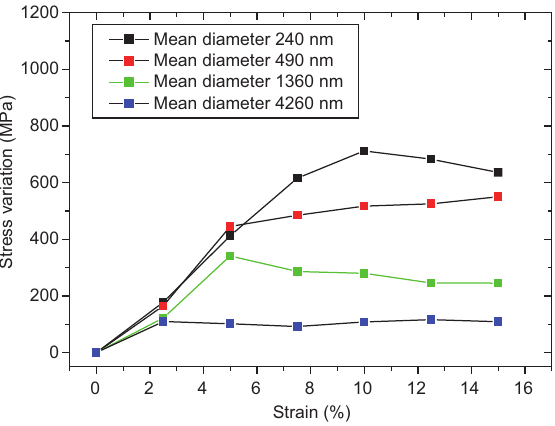
Figure 3 Scatter of deformation curves of Mo micropillars and nanopillars of different diameters. Each curve represents the standard deviation of the flow stresses of eight samples. Data from [1,